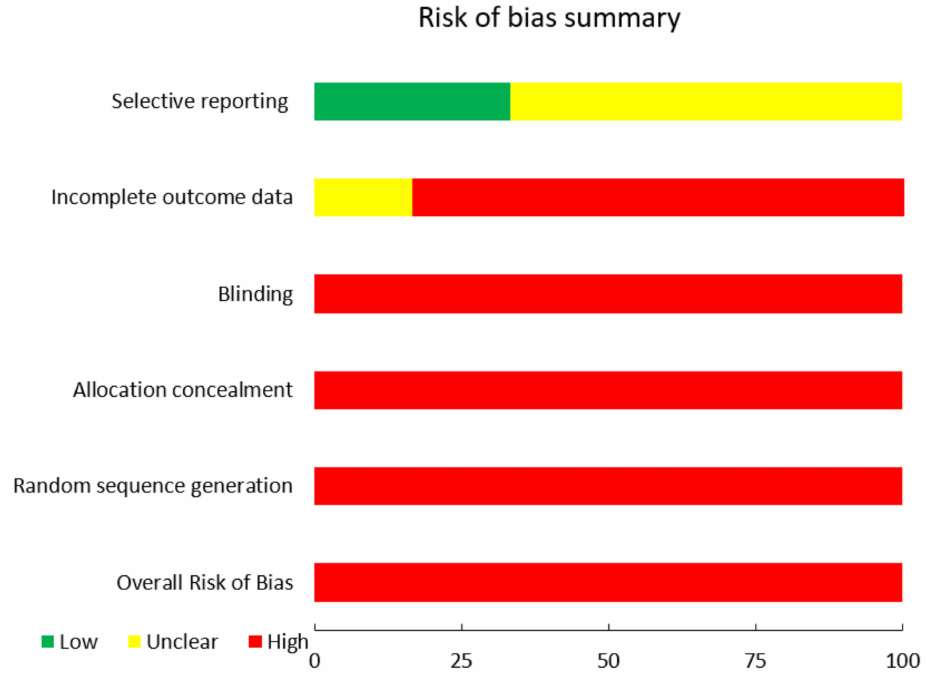
Figure 6. Risk of Bias